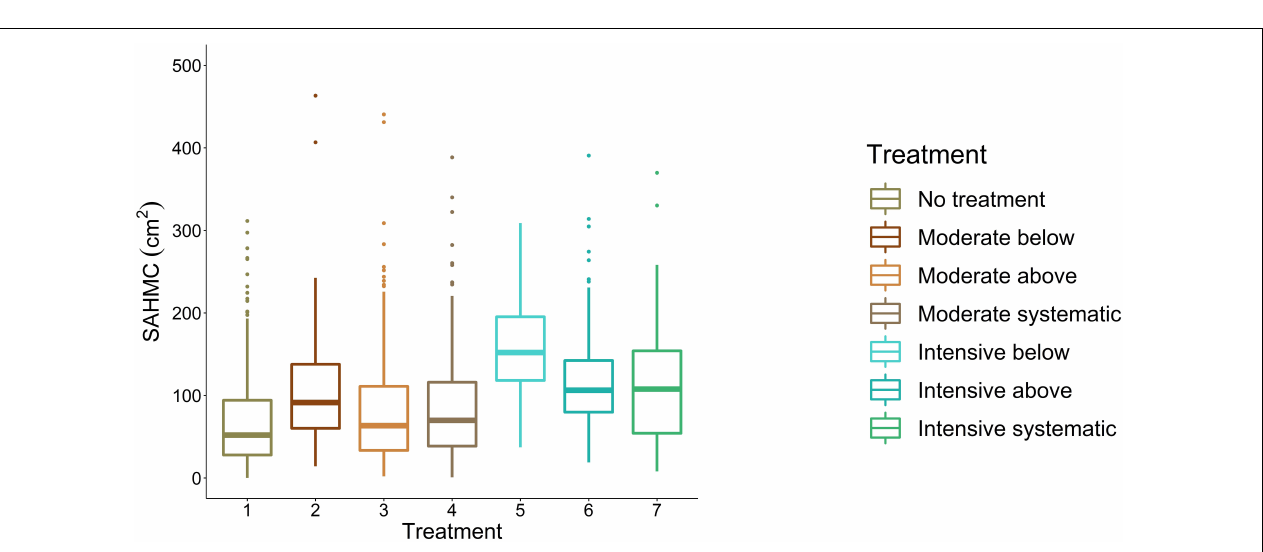
FIGURE 6 | Point clouds from example trees from different thinning treatments. Stem densities of the treatments were on average ∼ 1,250, 720, 910, 940, 290, 450, and 470 stems/ha for no treatment, moderate below, moderate above, moderate systematic, intensive below, intensive above, and intensive systematic, respectively.